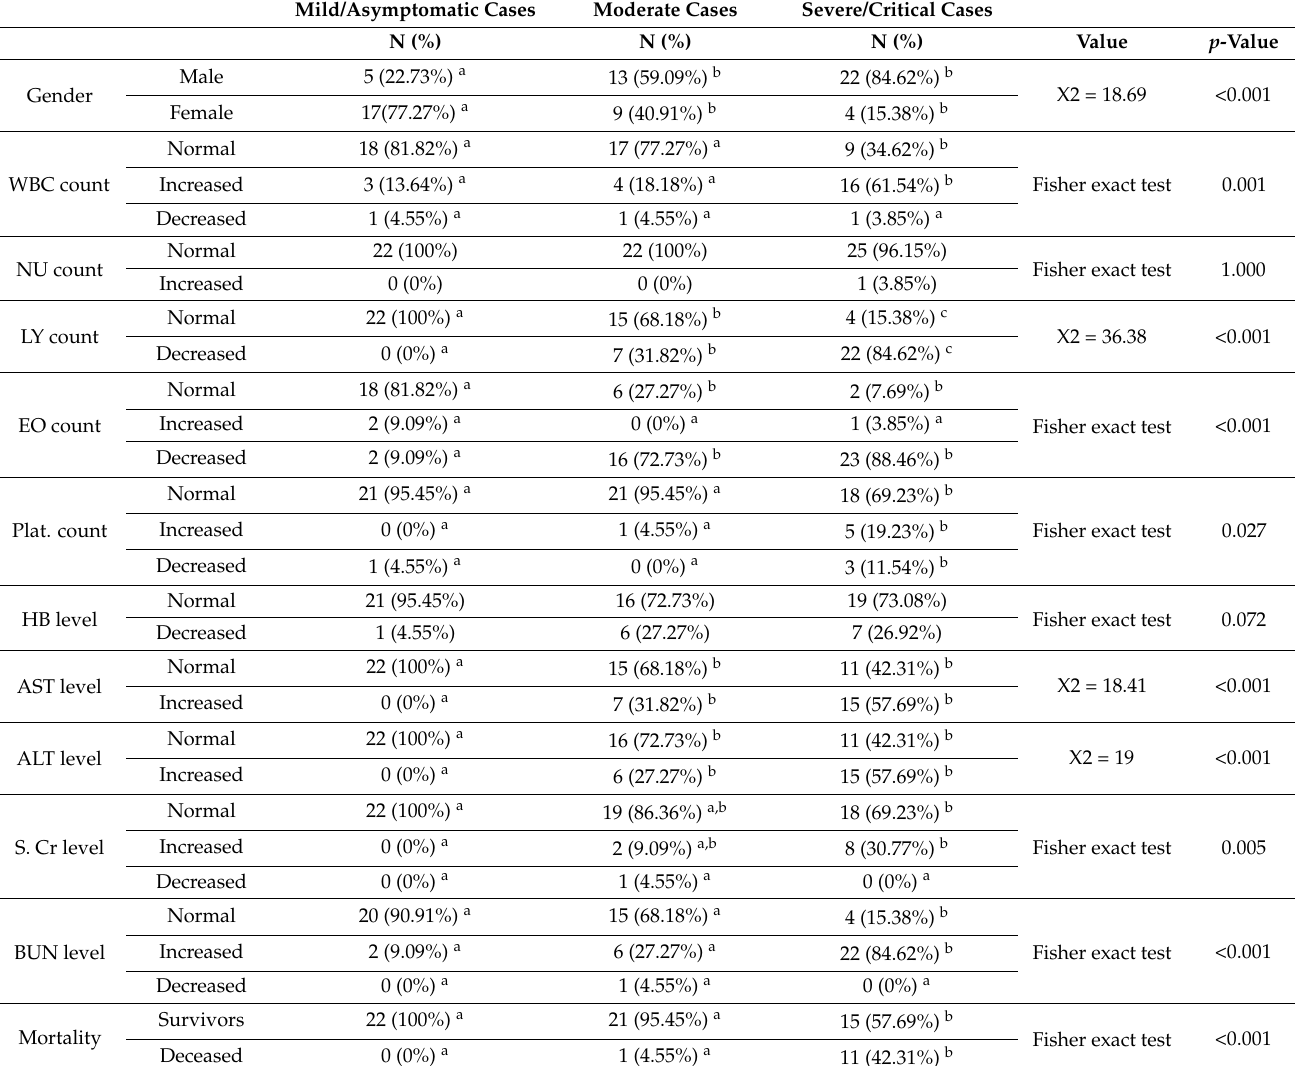
Table 6. Comparison of the gender, laboratory data distribution, and mortality between different patient